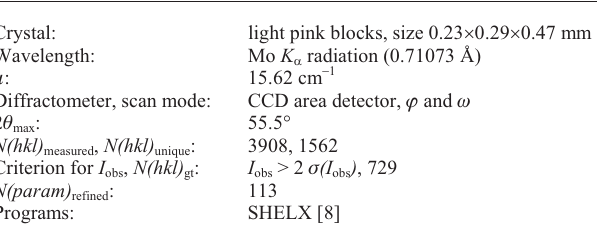
Table 1. Data collection and handling.